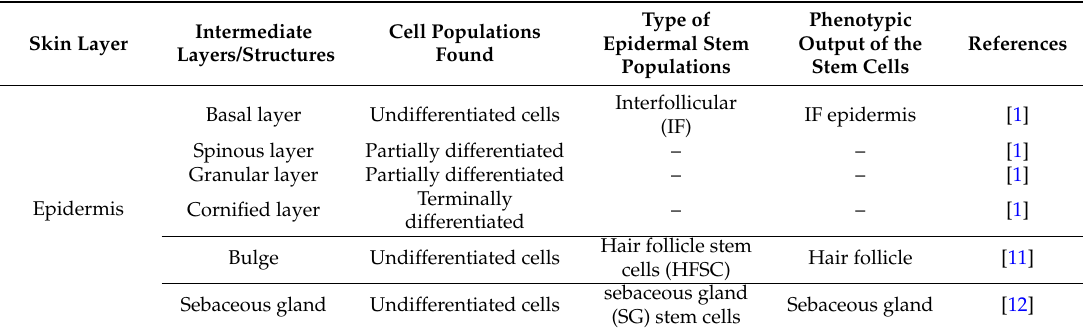
Table 1. Cell type distribution in epidermal